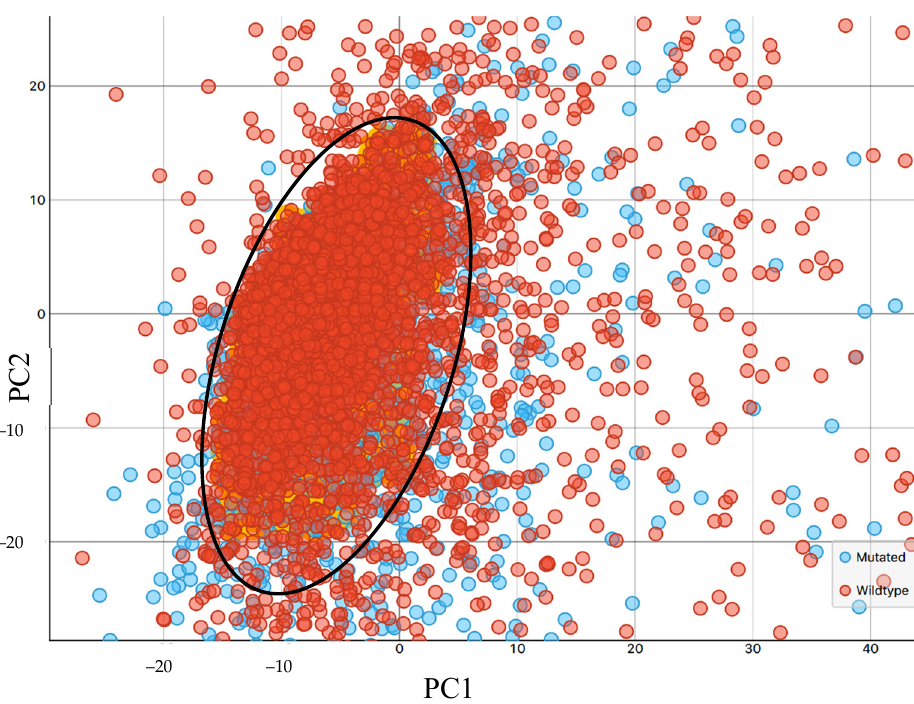
Figure 4. Principal component analysis (PCA)-based quality test: PCA scores plot of principal component 1 (PC1) and principal component 2 (PC2) with focus on centre of the cluster highlighting the ellipse (black circle) containing the data that were carried forward for investigation; all spectral datapoints laying outside of the ellipse were removed from subsequent analysis.